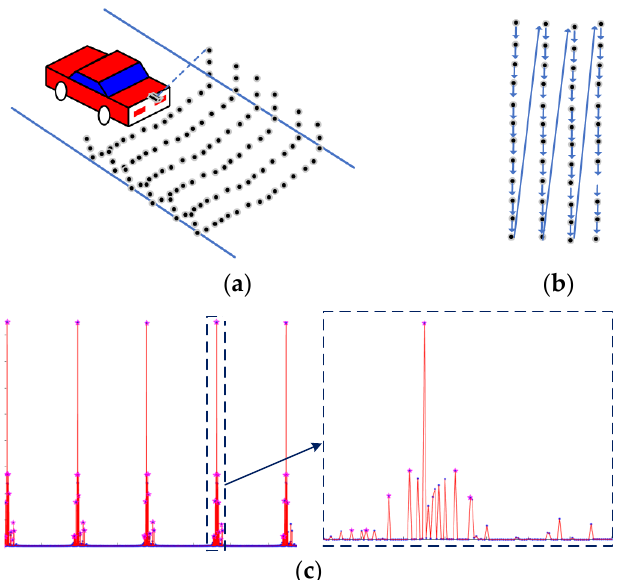
Figure 2. ( a ) Scan line; ( b ) Distance between scanning points; ( c ) Variation of distance between scanning points.